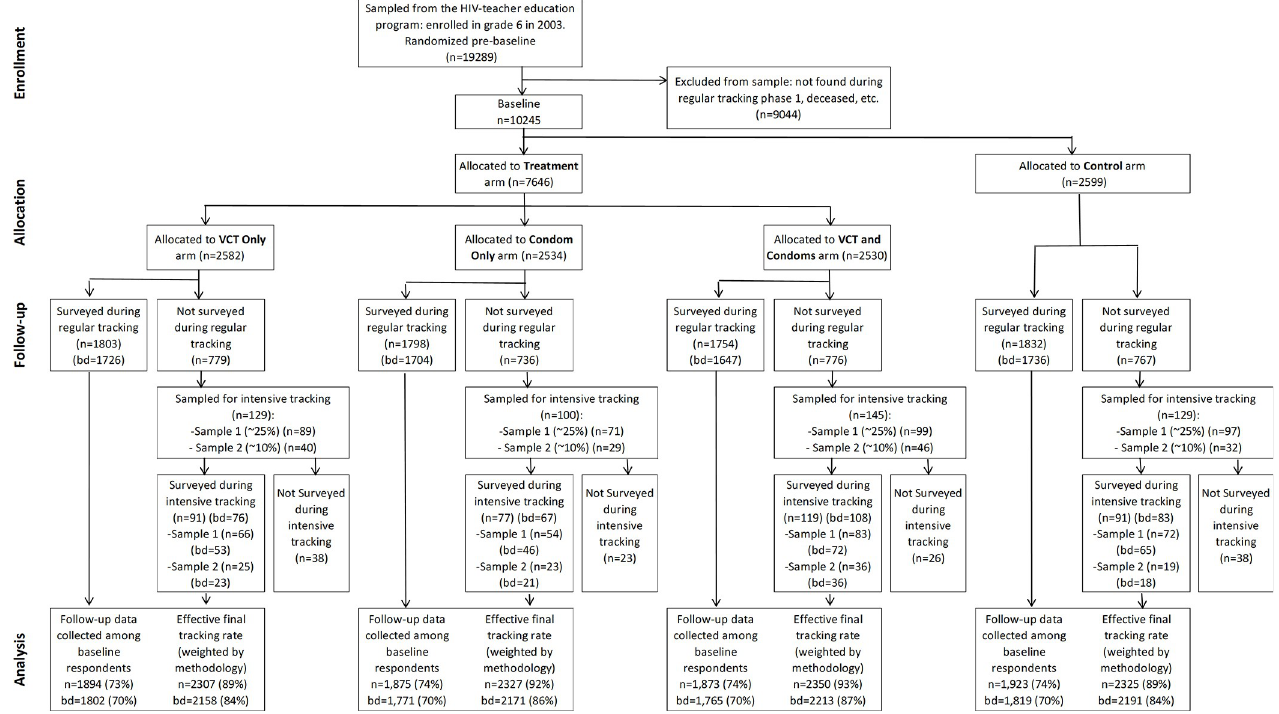
Fig 1. Participant flow diagram. Note: "bd" gives the number of respondents for whom a blood draw was successfully taken. a: the effective final tracking rate combines regular and intensive tracking rates, and provides an estimate of the share of the total sample for which the data are representative.